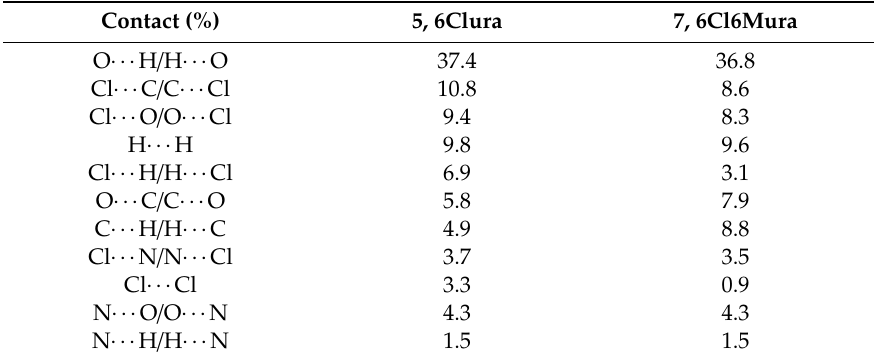
Table 6. Contributions of the intermolecular contacts for compounds 5 and